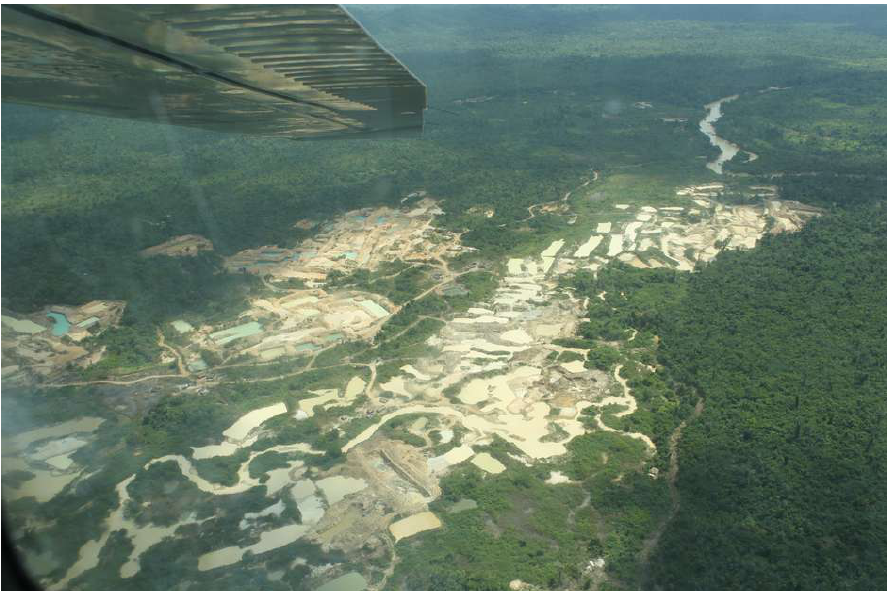
Figure 1. Illegal mining fronts in Kayapó Indigenous Land, Pará. Photo: Ibama/BBC News